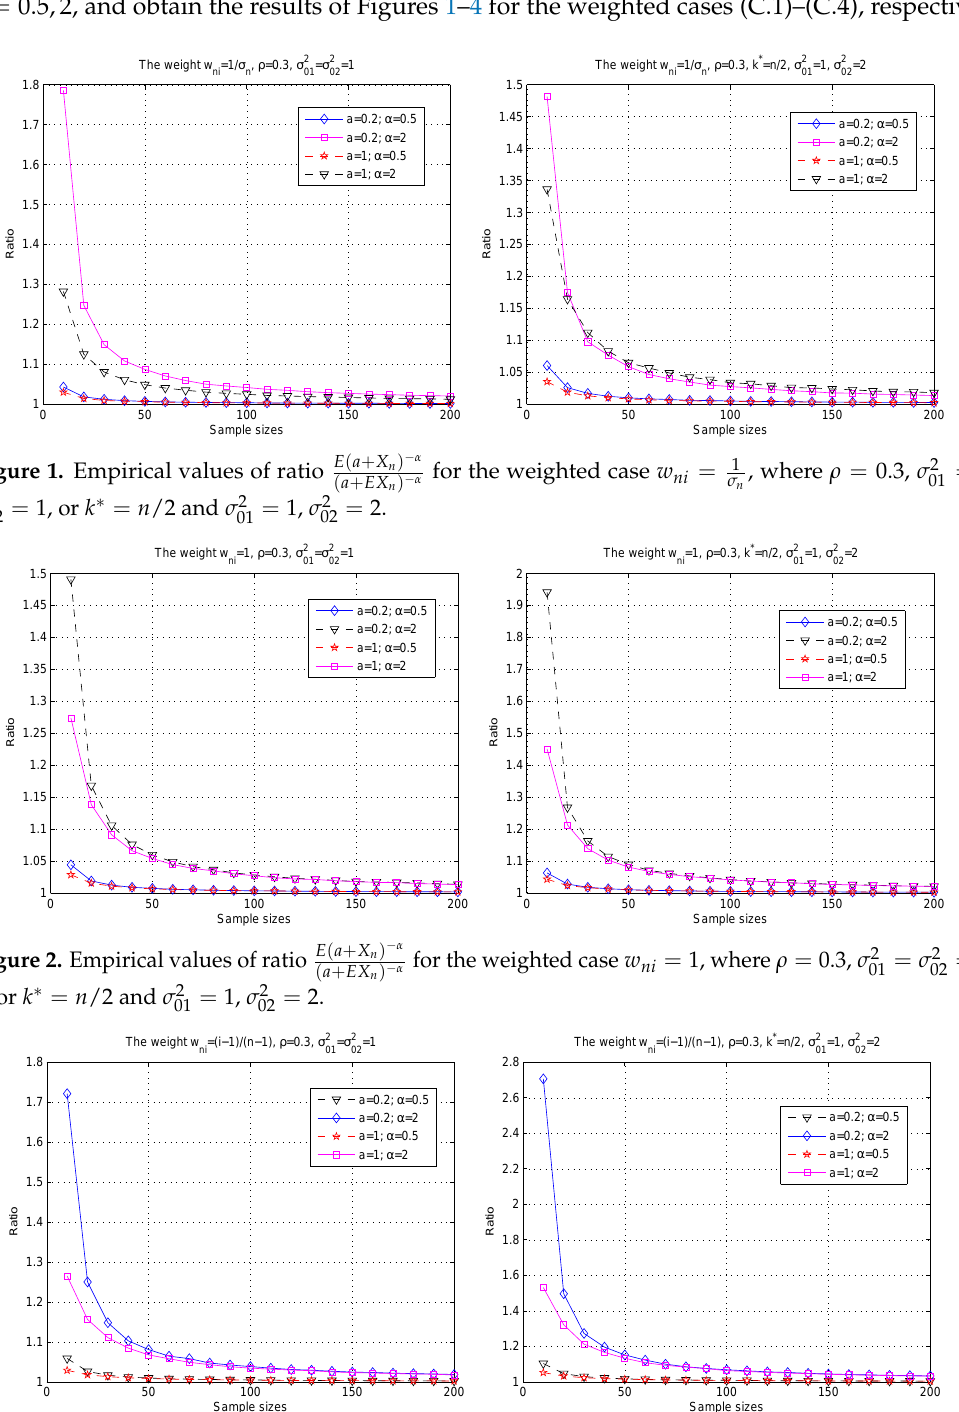
− α for the weighted case w ni = i − 1 ( a + EX n ) − α = 1, σ 2 = 02 01